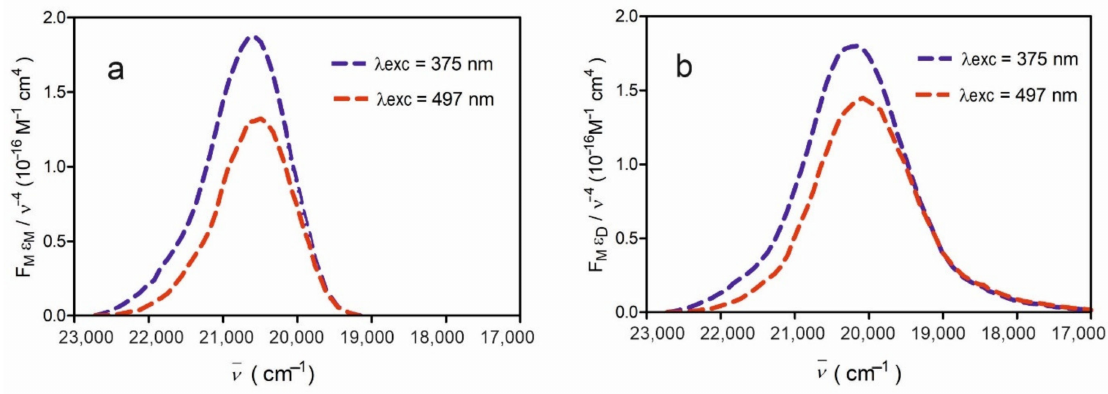
(cid:16) (cid:17) (cid:16) (cid:17) ν 4 ν 4 ; ( b ) F M ( ν ) × ε D ( ν ) / , of overlap integrals